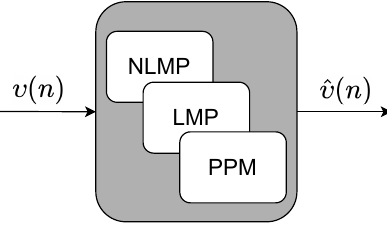
Figure 2. Structure of the prediction modules, MPD and